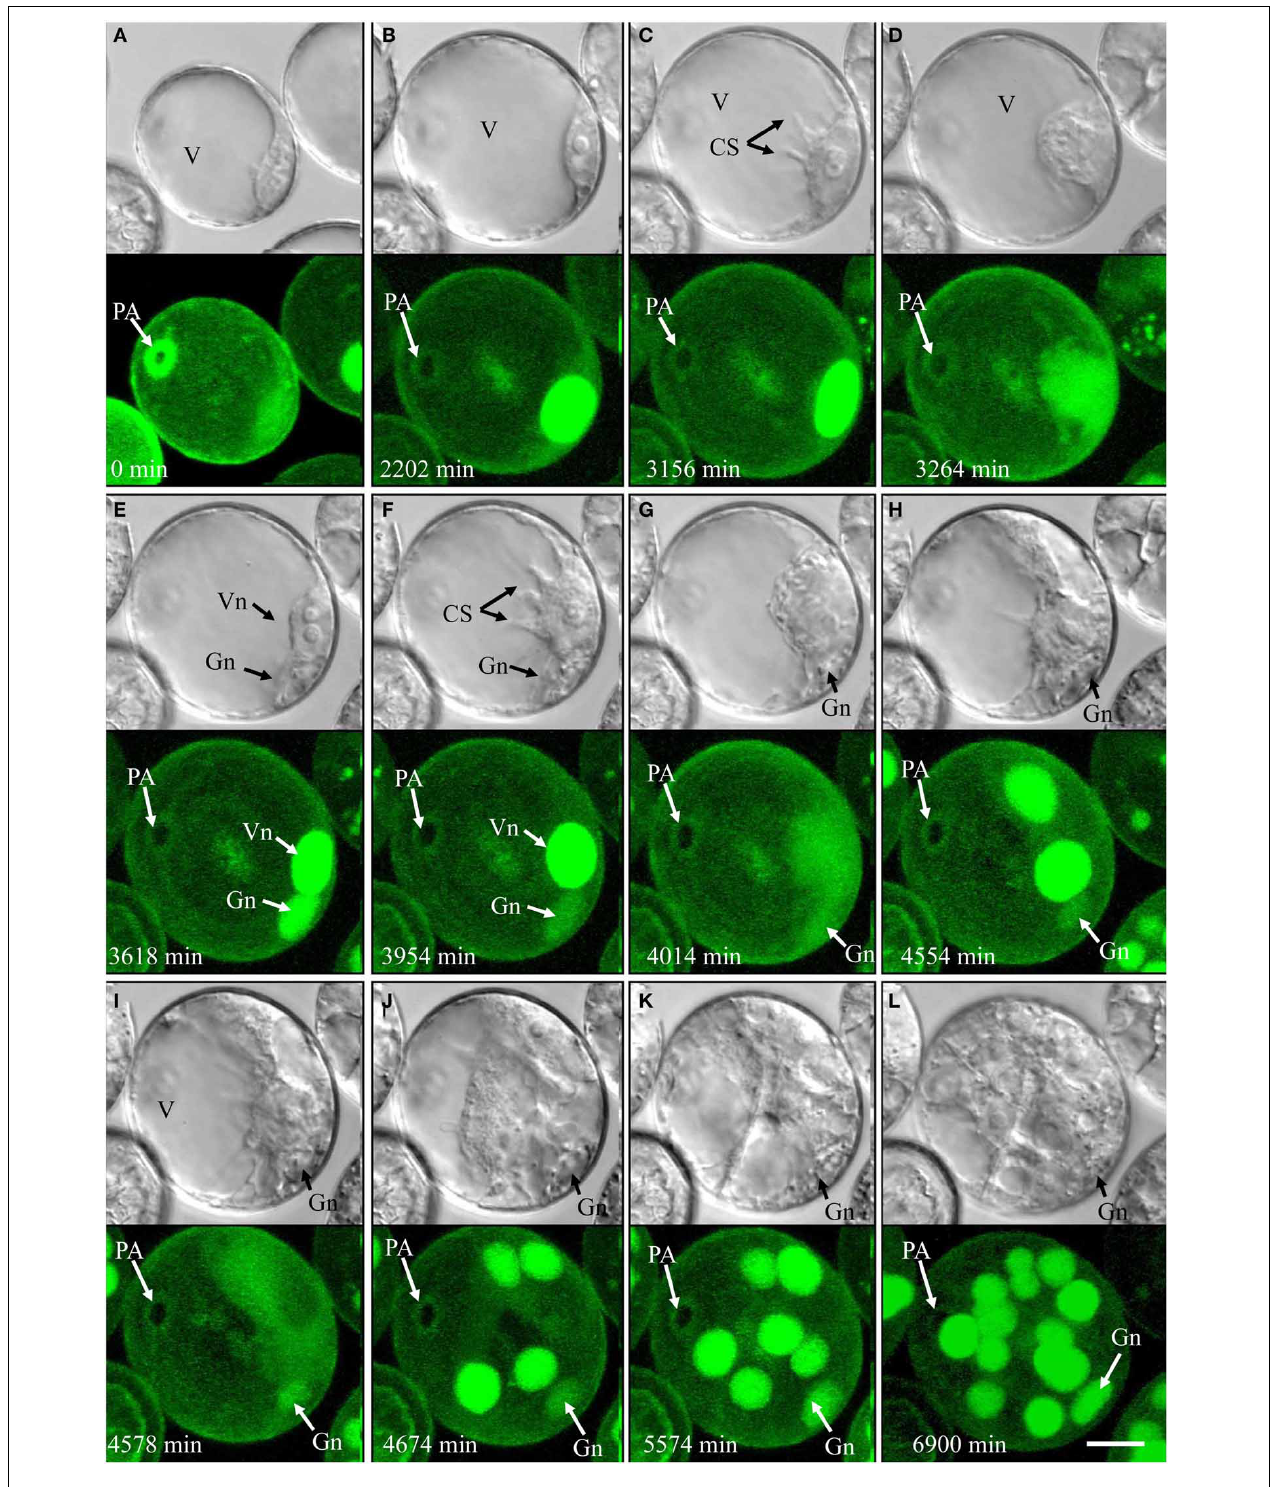
FIGURE 4 | Time-lapse of type IV development (embryogenic pollen) shown by synchronously acquired DIC and fluorescence images. (A) Uni-nucleate pollen with large vacuole and thin layer of peripheral cytoplasm. (B) Uni-nucleate pollen increases in size. (C) Cytoplasmic strands appear prior to pollen mitosis I. (D–F) Large spherical vegetative-like nucleus and smaller